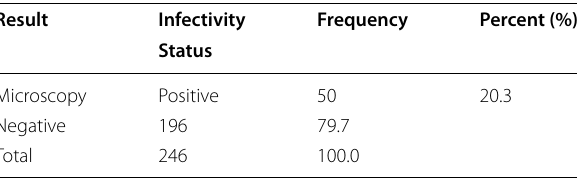
Table 1 Prevalence of lymphatic filariasis in Imobi, Ijebu East Local Government Area